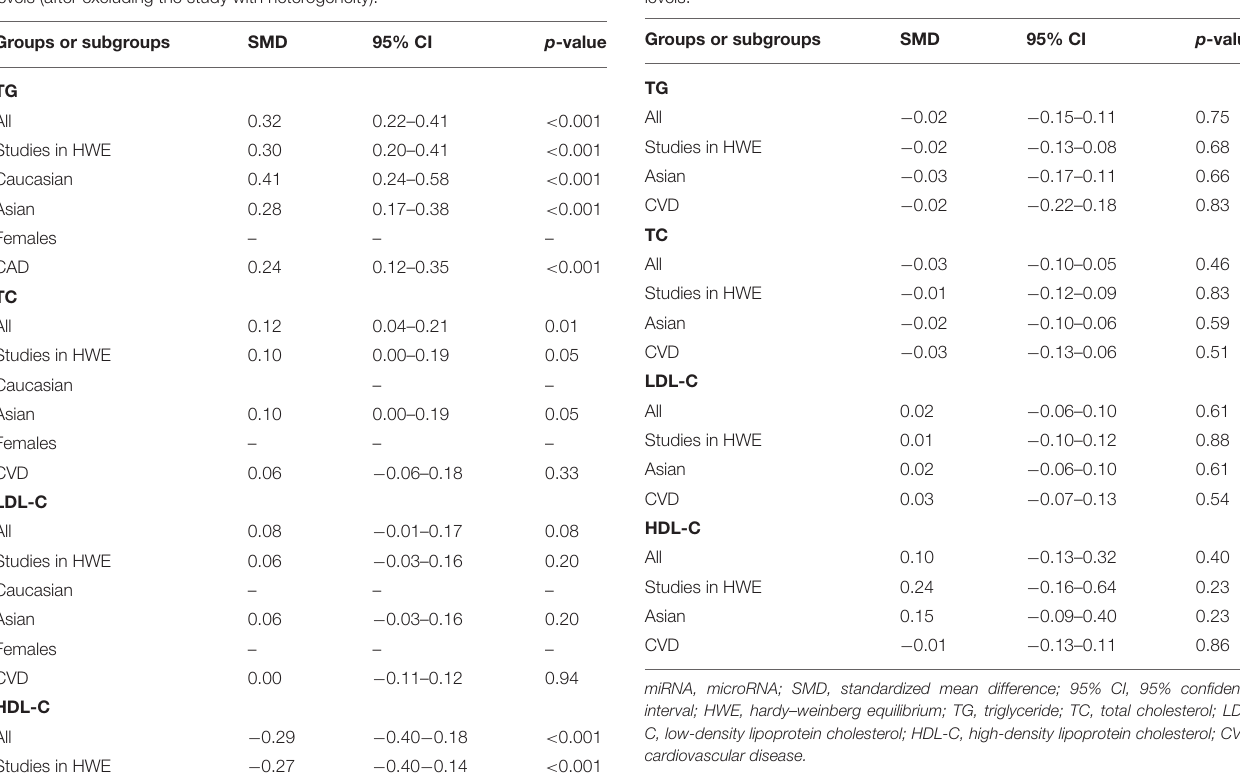
polymorphism with the TC ( Supplementary Figure S5 ), LDL-C ( Supplementary Figure S6 ), and HDL- C ( Supplementary Figure S7 ) levels. However, one comparison the significant polymorphism with the TC ( Supplementary Figure S8 ), ( Supplementary Figure S9 ), and HDL-C ( Supplementary Figure S10 ) levels as well as the significant correlation between the rs3746444 polymorphism and TG ( Supplementary Figure S11 ) levels, while another comparison (Qiu et al., 2020) may affect the correlation between the rs2910164 polymorphism and TG ( Supplementary Figure S12 ) levels. The correlations between the rs2910164 and rs3746444 polymorphisms and lipid levels did not change